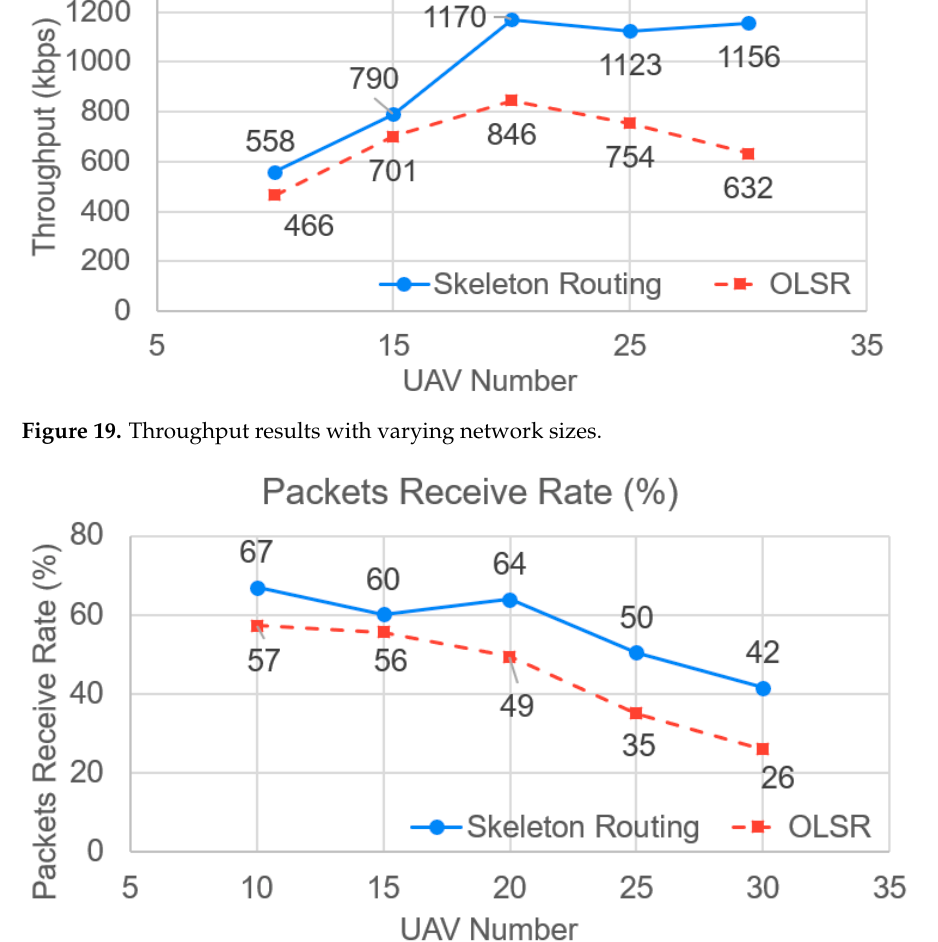
Figure 21. Overhead results with varying network sizes. 7.2. Performance with Different Mobility Speeds Further tests were performed to verify the effects of node movement speeds. The network size was kept at 20. Constant node speeds with 10, 20, 30, and 40 m/s were tested. Figure 22 shows the throughput results. Figure 23 shows packet reception rate results. Our routing scheme performed better than OLSR for all four-speed settings. The speed does not have big effects on protocol overhead. The OLSR has around 60% overhead for all situations, our routing scheme has around 13% overhead.